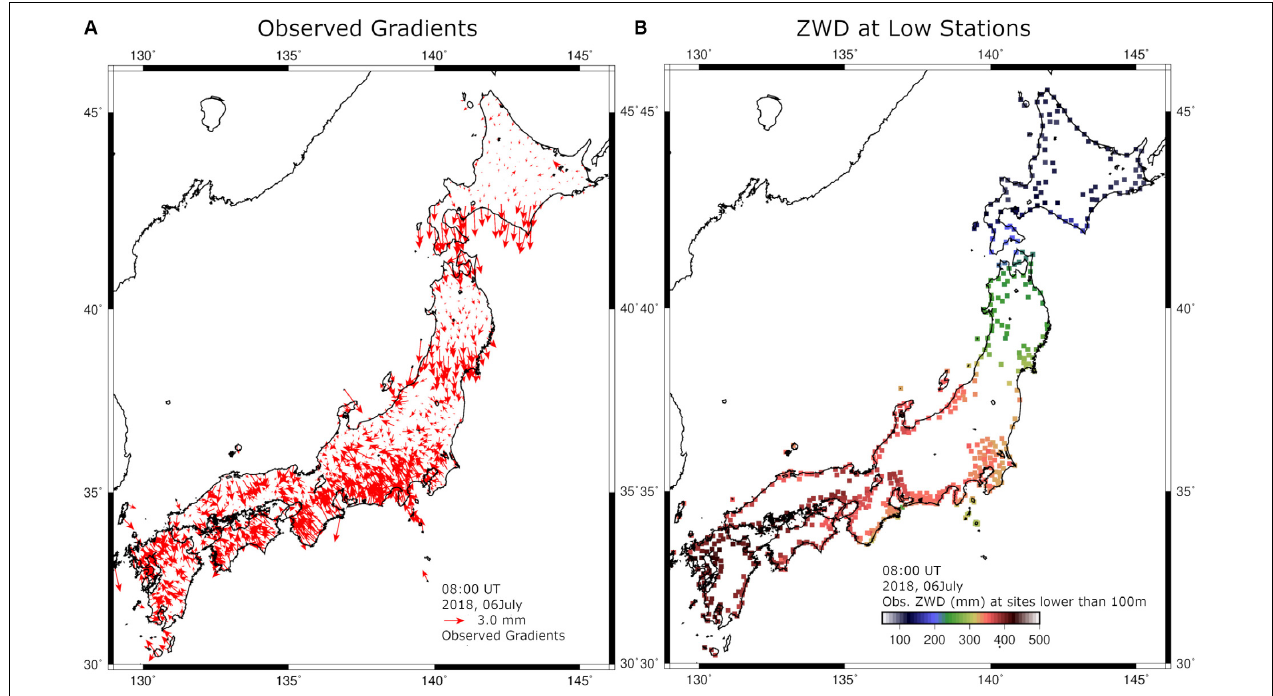
FIGURE 4 | Input data for the inversion of sea-level ZWD at 17 JST (08 UT) on July 6, 2018. (A) shows the tropospheric delay gradients at all the GEONET stations, and (B) is the ZWD at stations with elevations < 100 m. Using these inputs, we estimated sea-level ZWD at all the grid points shown in Figure 5A .